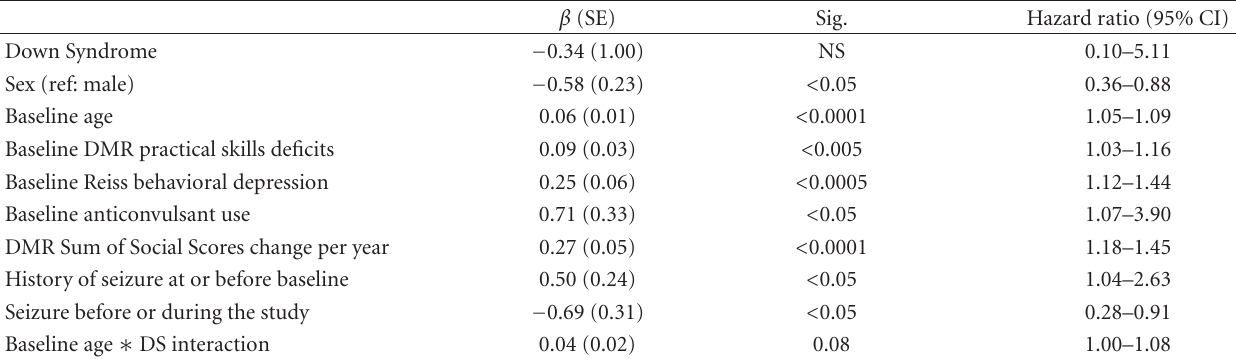
Table 5: Multivariate Cox regression analysis of mortality, as of July 2011.